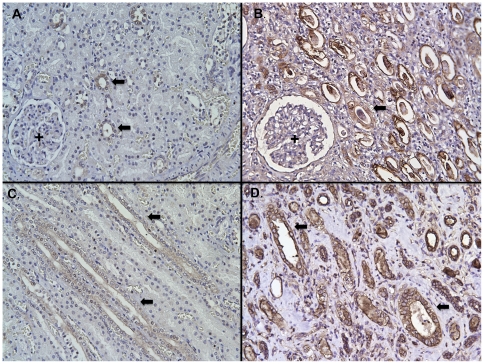
HD5 production in non-infected human kidney and kidney with pyelonephritis.Immunohistochemistry demonstrates HD5 production in isolated renal tubules (brown/arrows) in non-infected renal cortex (A) and medulla (C). With pyelonephritis, HD5 production increased in the renal tubules of the cortex (B) and medulla (D). The glomeruli (+) show no immunostaining in non-infected kidney samples and with pyelonephritis. Negative controls showed no immunostaining (not shown). Magnification 20×.